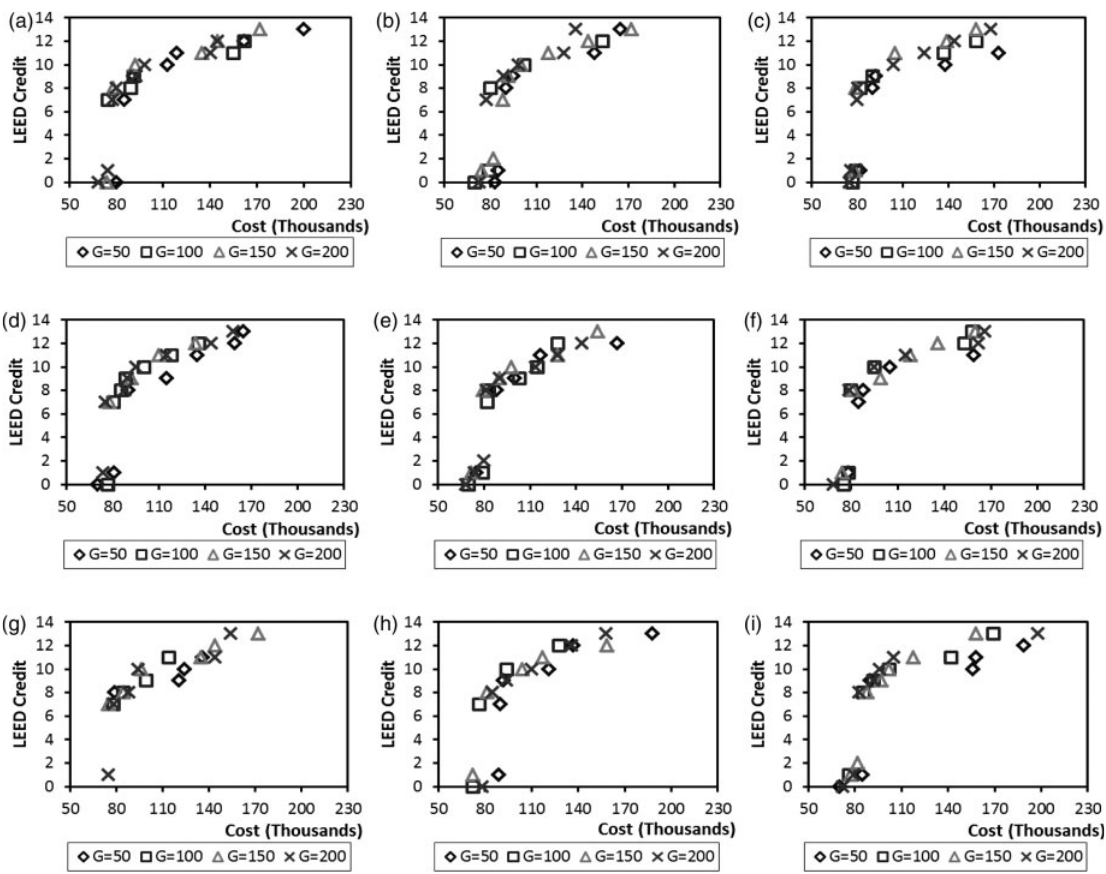
Fig. 4. Sensitivity analysis of ACMO parameters: (a) r (cid:3) 0.3, R (cid:3) 100; (b) r (cid:3) 0.3, R (cid:3) 50; (c) r (cid:3) 0.3, R (cid:3) 10; (d) r (cid:3) 0.6, R (cid:3) 100; (e) r (cid:3) 0.6, R (cid:3) 50; (f) r (cid:3) 0.6, R (cid:3) 10; (g) r (cid:3) 0.8, R (cid:3) 100; (h) r (cid:3) 0.8, R (cid:3) 50; (i) r (cid:3) 0.8, R (cid:3) 10